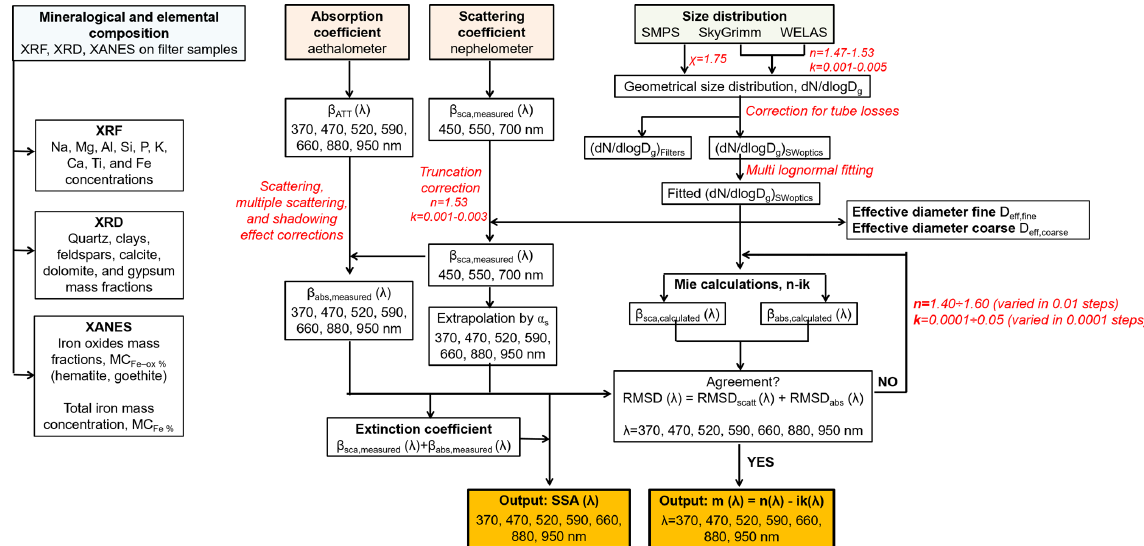
Figure 1. Flowchart illustrating the procedure for data treatment and retrieval of the physical and chemical (size, composition) as well as spectral optical properties (single-scattering albedo (SSA) and complex refractive index) of mineral dust aerosols. In red we mention the different corrections performed and the values adopted in the calculations. The α s symbol in the scheme indicates the SAE 450–550 and the SAE 550–700 Ångström exponents used to extrapolate the nephelometer data at the aethalometer